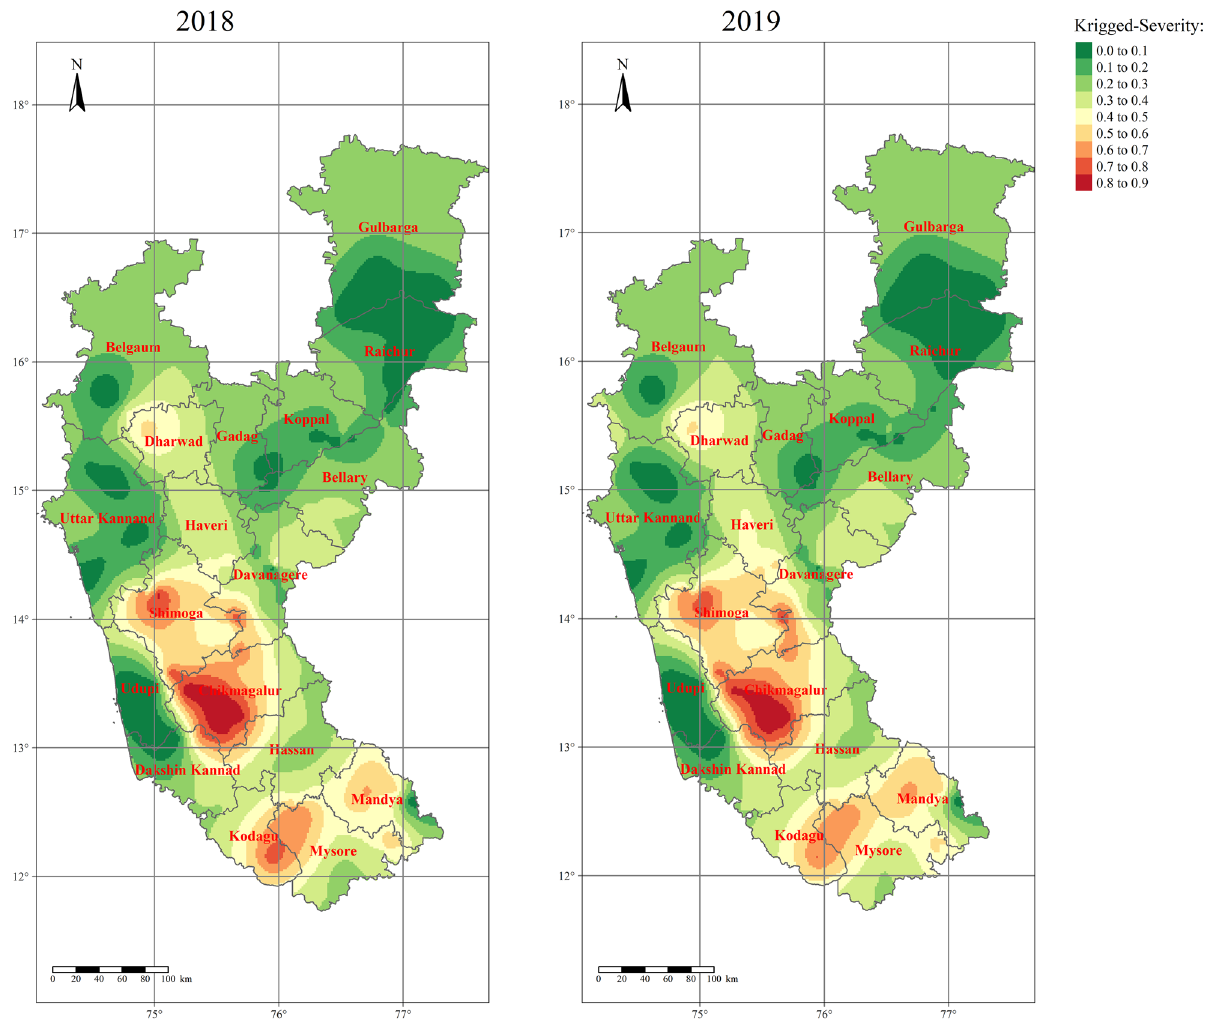
Figure 10. Ordinary kriging interpolated maps representing the spatial distribution of RBD in different rice ecosystems of Karnataka during 2018 and 2019. Green to red-color coded surfaces depicts lower to higher disease severe points. The maps were created using R software (version